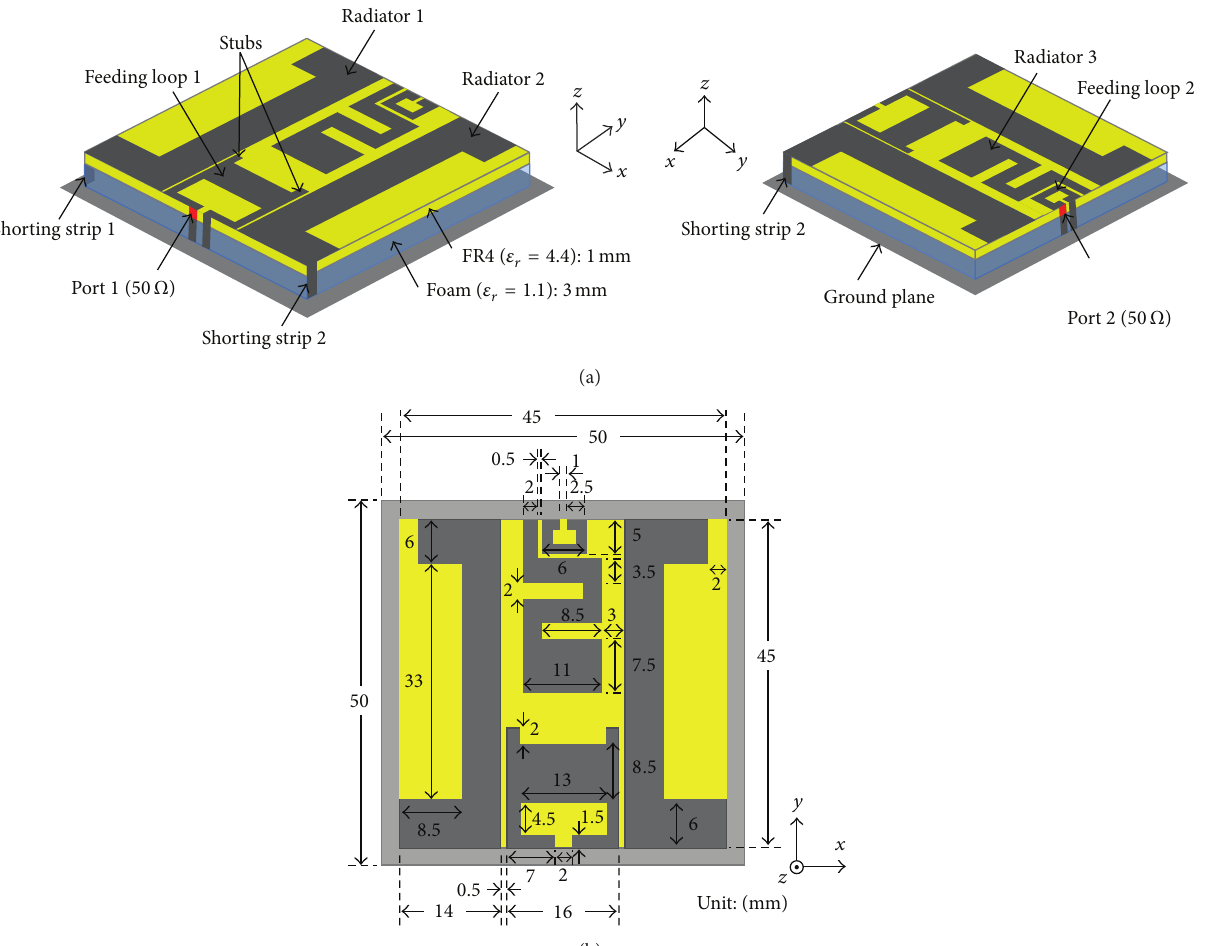
Figure 1: Structure of the proposed dual-band RFID tag antenna: (a) overall view and (b) top view with detailed dimensions.